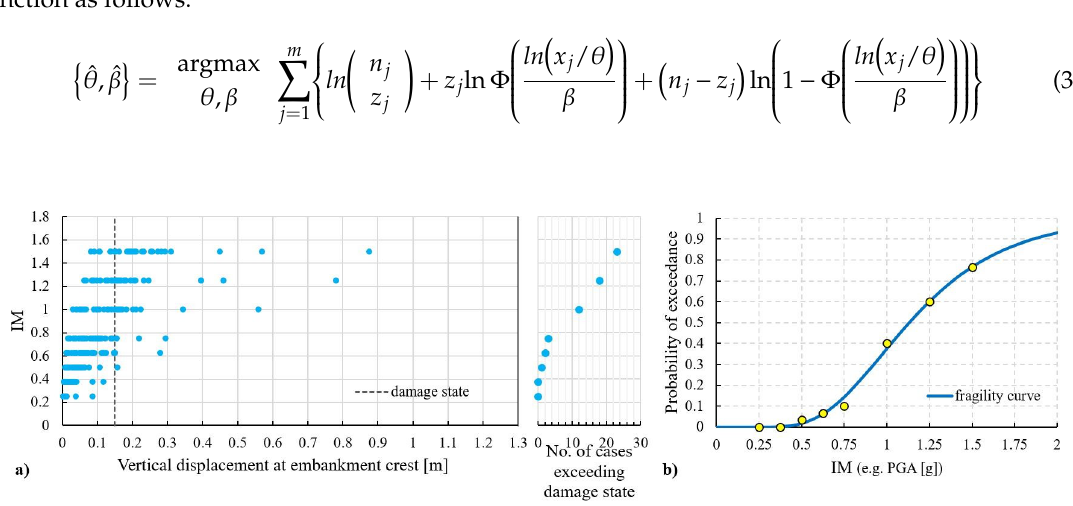
Figure 1. Example of the results of a seismic response assessment, with identification of the number of cases exceeding a selected damage state ( a ), and the corresponding fitted fragility curve ( b ).